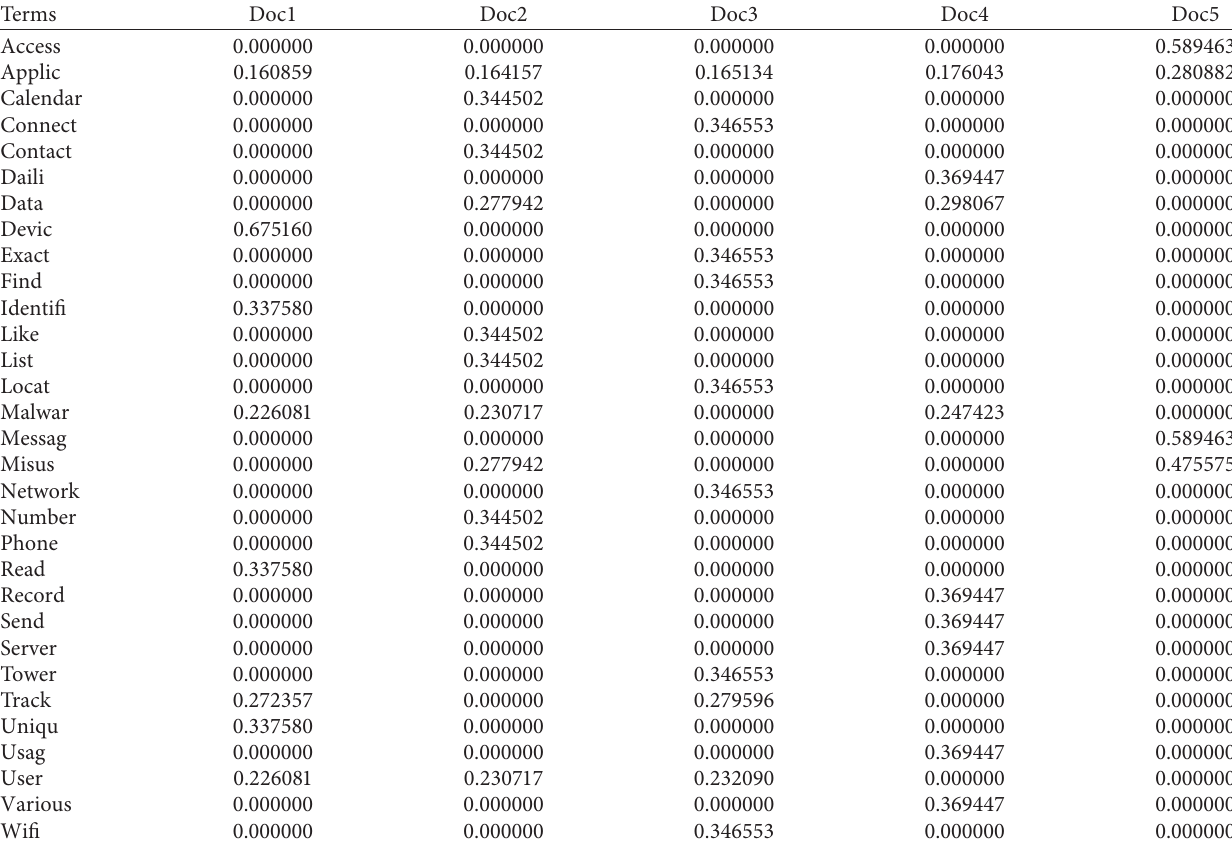
Table 6: Transformed term frequencies after TF-IDF generation.